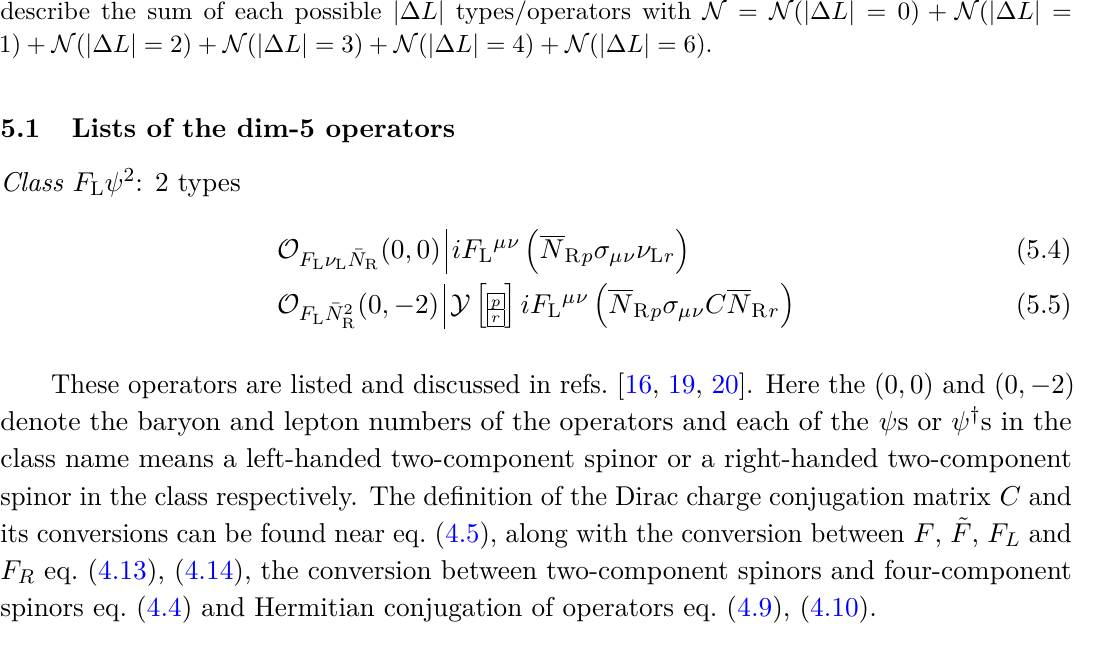
Table 7 . The complete statistics of dimension 9 ν LEFT operators. The numbers under N type describe the sum of each possible | ∆ L | types/operators with N = N ( | ∆ L | = 0) + N ( | ∆ L |